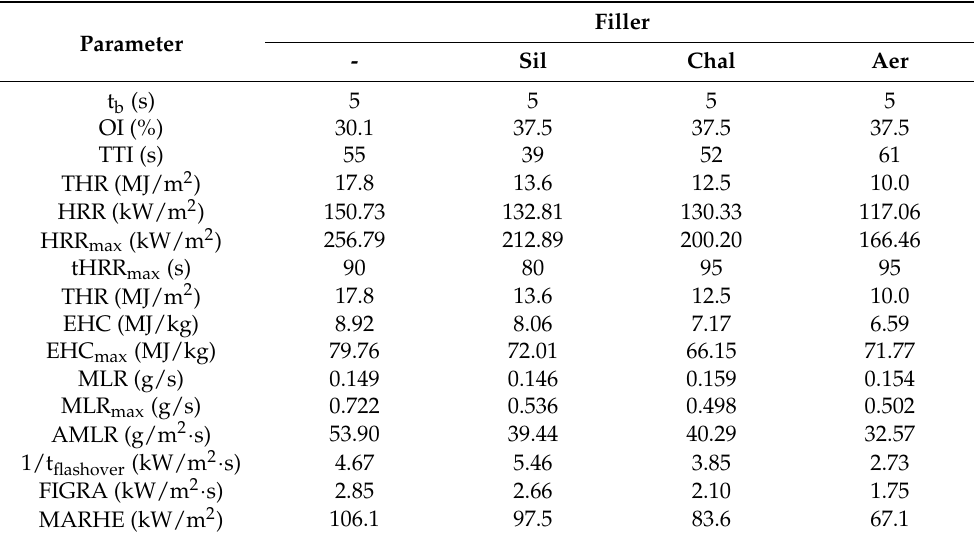
Table 4. Parameters characterizing the flammability and fire hazard of the unfilled or filled vulcan- izates, determined by oxygen index and cone